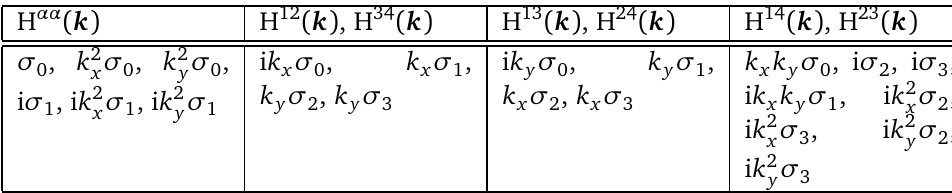
Table 2: Terms (upto second-order in momentum) that can appear for eight-band k · p Hamiltonian